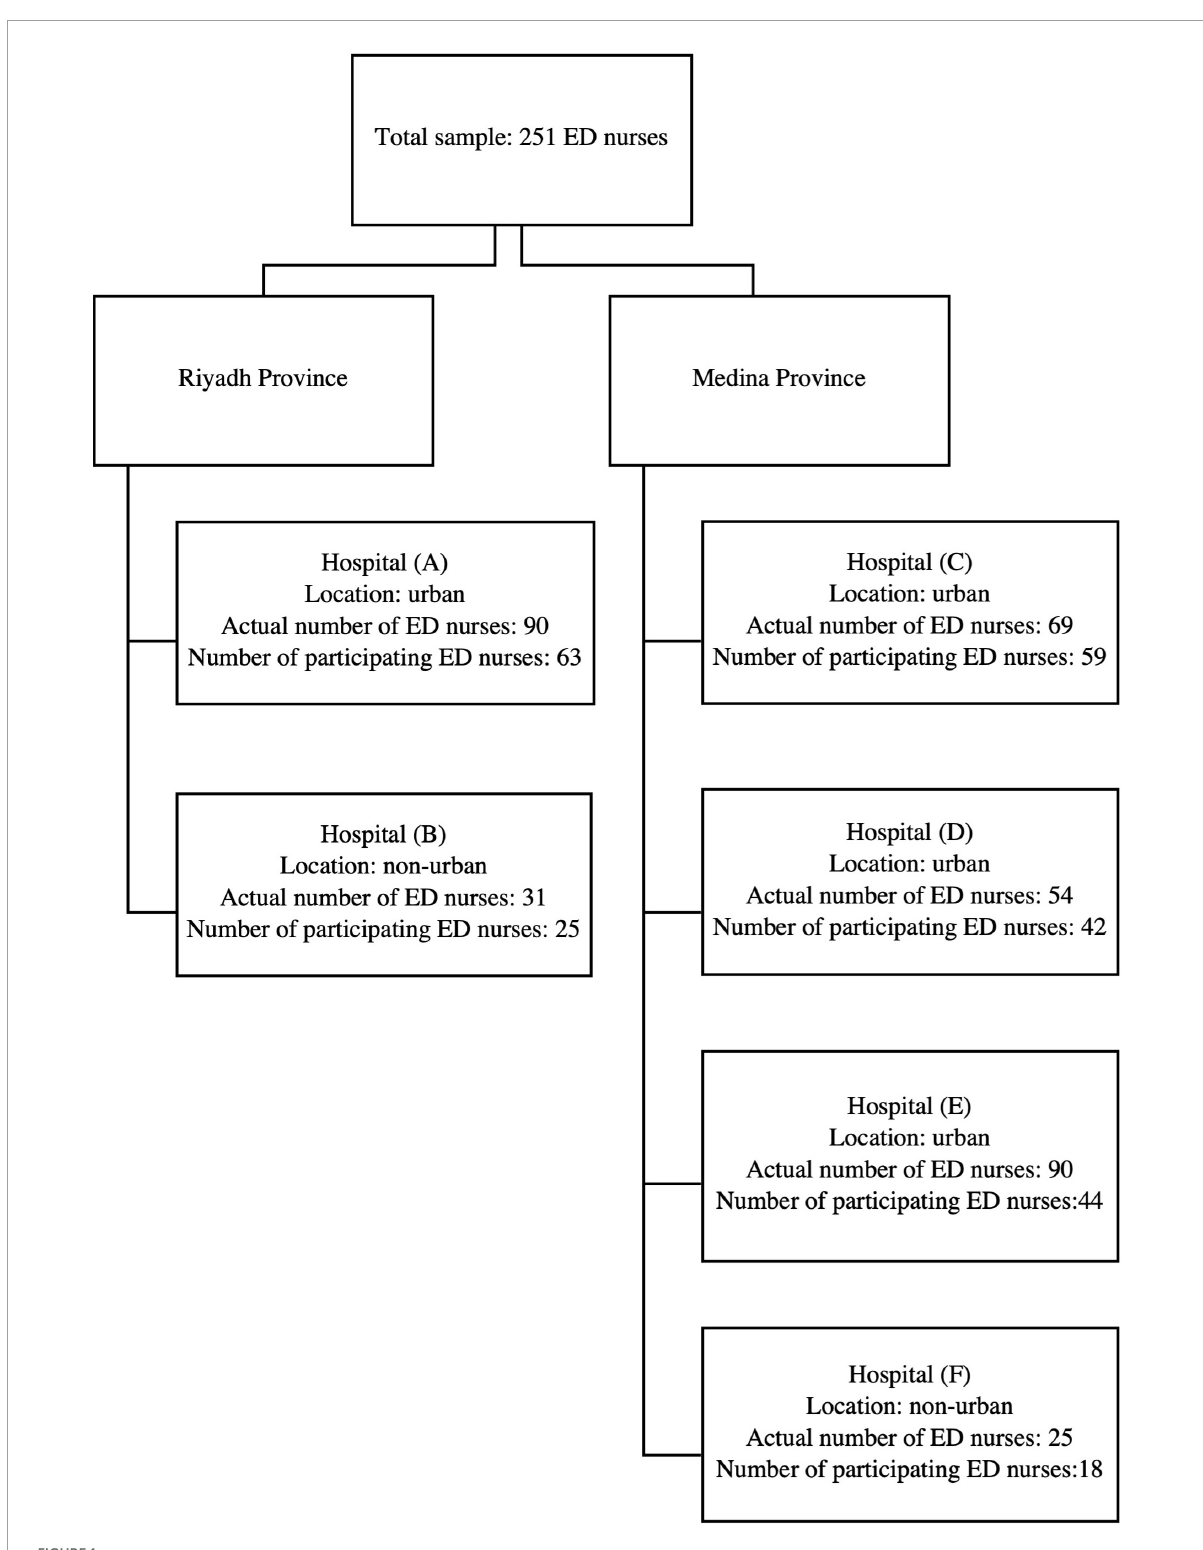
FIGURE1 Number of ED nurses approached versus the number of ED nurses who